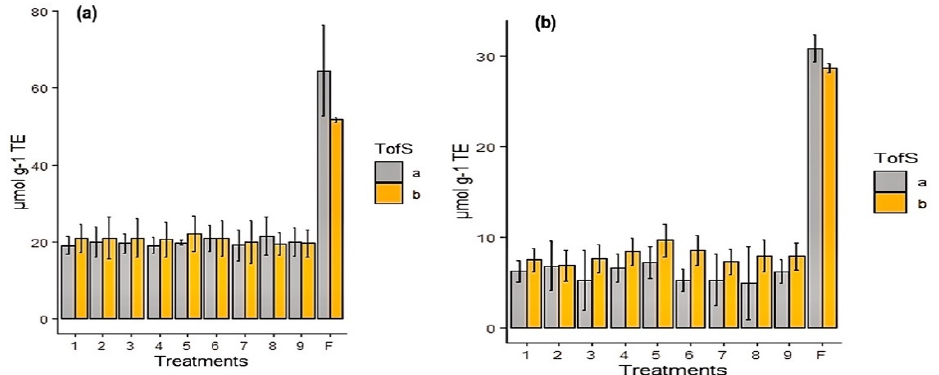
Figure 2. Antioxidant and enzymatic activity of encapsulated calafate at two storage temperature (TofS, temperature of storage a = 5 °C, b = 35 °C) 1–9 spray dried treatments, freeze-dried (control process). ( a ) DPPH assay: Comparison between nine formulations by spray-drying, with freeze- drying of calafate as a control process; ( b ) ORAC assay: Spray-drying formulation, with freeze-drying of calafate as a control process.